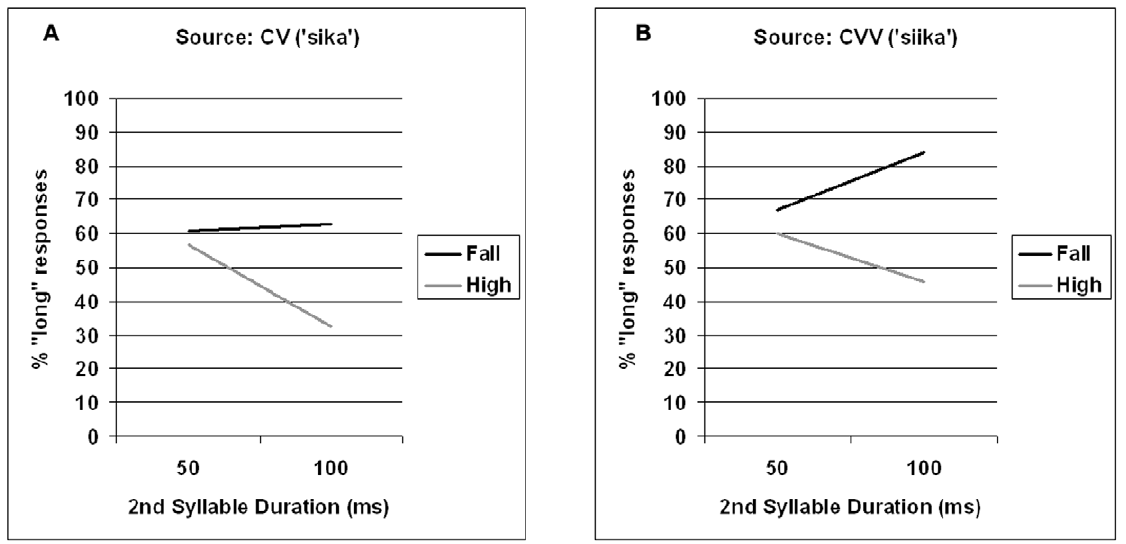
Figure 2. Effects of second syllable duration and Tone in Experiment 1. Effects of second syllable duration (75–175 ms) and type of tone (high, fall) in Experiment1 for source words with short (panel A) and long (panel B) syllables.